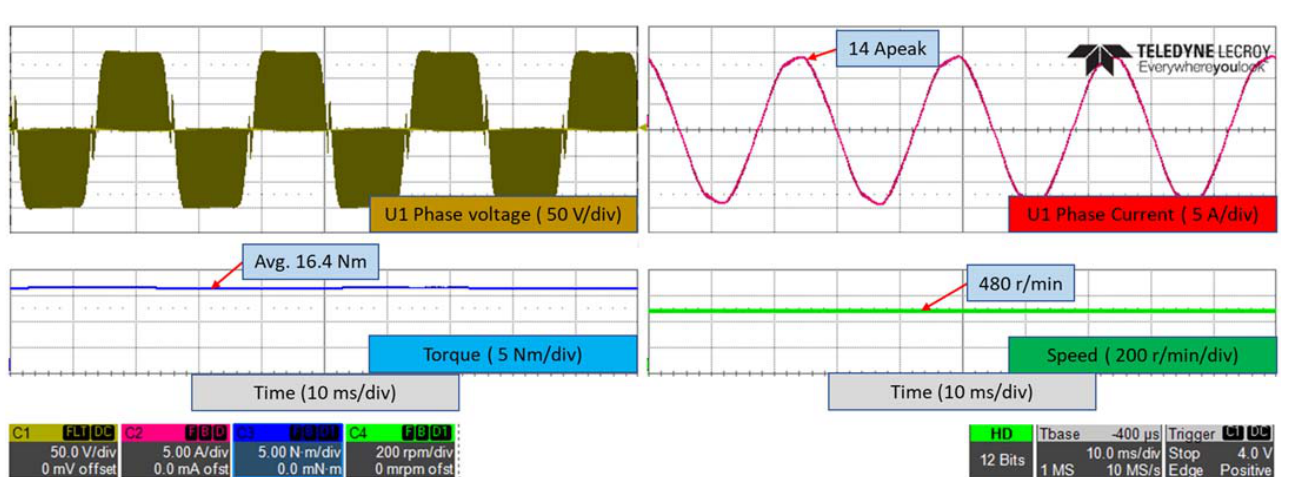
Figure 13. Torque curves at 480 r/min and 10 A for six-phase operation.